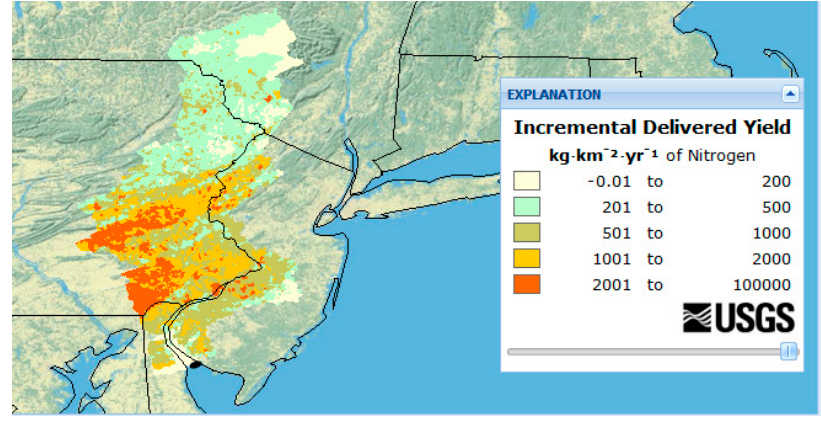
Figure 7. Incremental delivered nitrogen yield to Delaware Basin from SPARROW model. Table 5. Nitrogen loads in Atlantic Coast river basins from USGS SPARROW model.